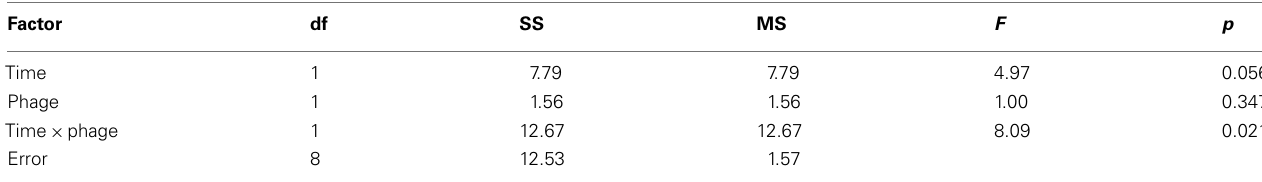
Table 4 |ANOVA results on the number of morphotypes (time-averaged for days 8–10) for the difference between early and late arrival of focal genotypes.